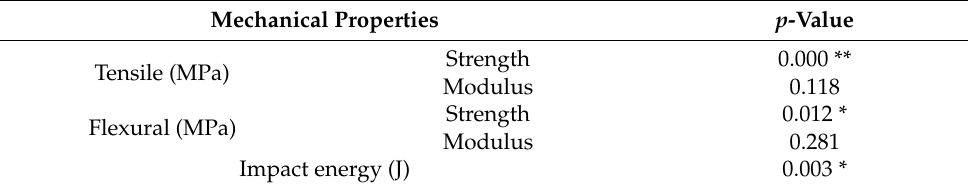
Table 3. Variance analysis of wood flour size effect on the mechanical properties ( p